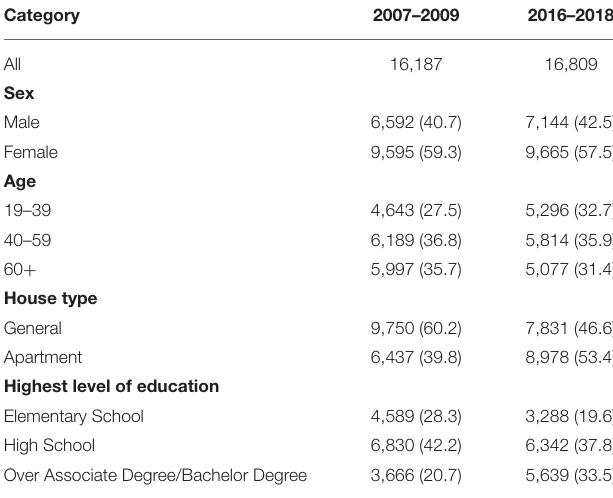
TABLE 1 | Characteristics of survey